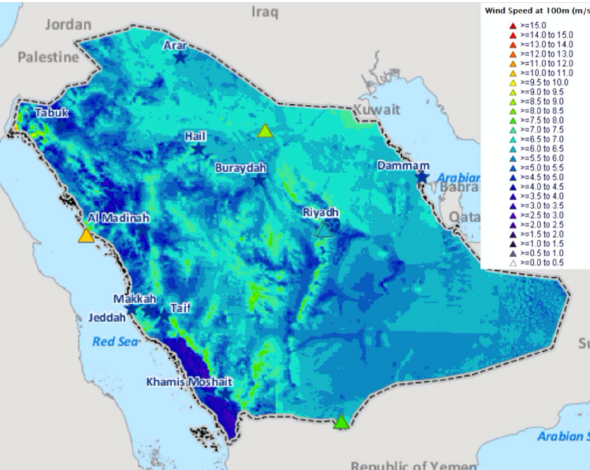
Figure 3: Map of wind speed data at 100 m in KSA